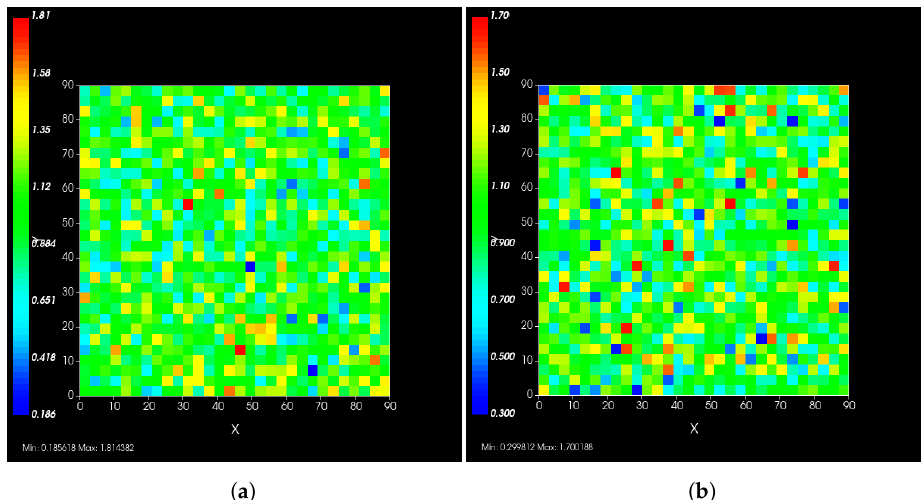
Figure 2. Simulated epithelial cell layers colored by the change in k in ( a ), k out ( b ). The values displayed are relative to the base k in and k out , a cell colored blue in ( b ) has, e.g., k (cid:48) out ( σ ) = 0.3 × k out